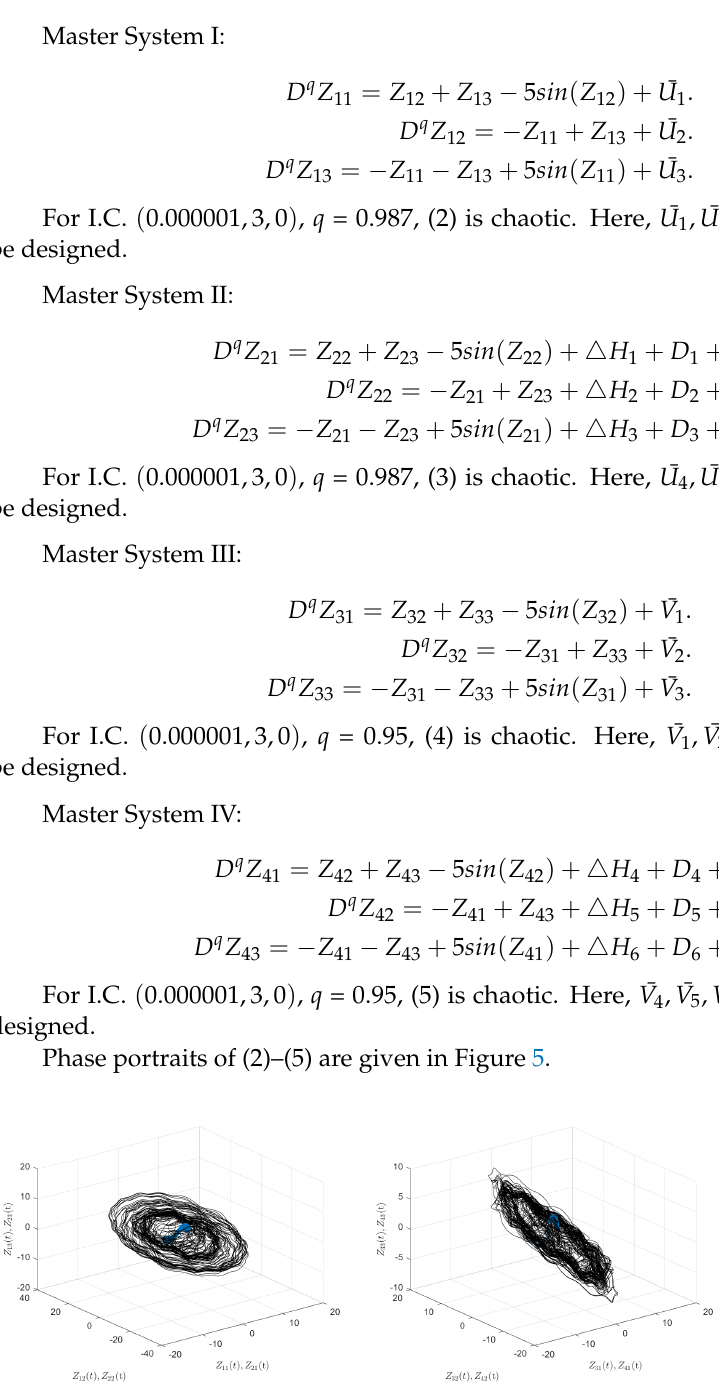
Figure 5. Phase portraits of Master Systems